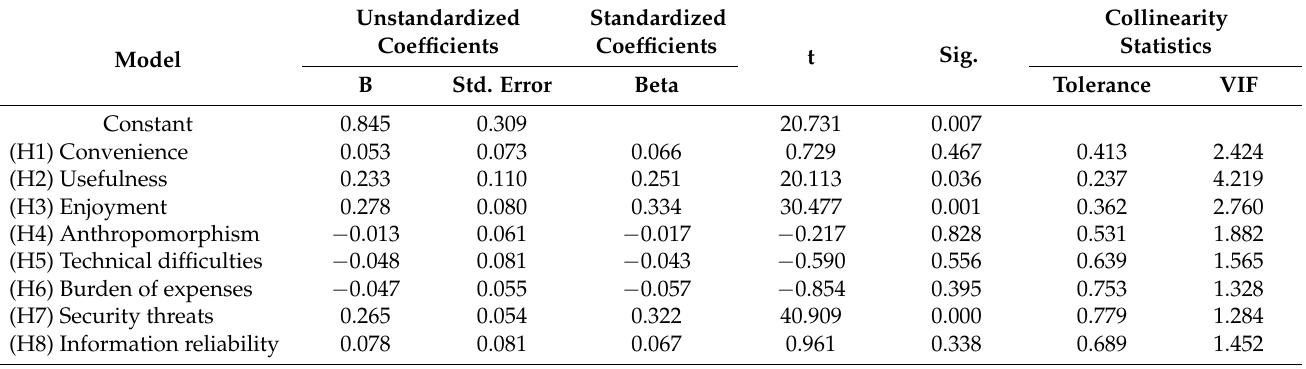
Table 6. Results of regression analysis of antecedent variables affecting perceived